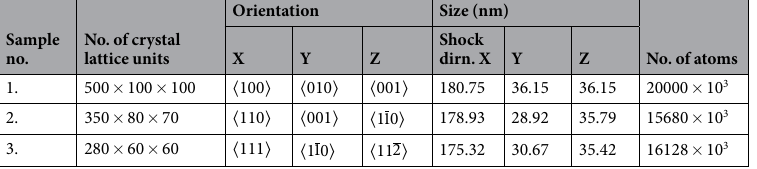
Table 1. Necessary details of the initial configurations of the samples for NEMD simulations with desired orientations. The mass density of all the samples are 8.806 g/cm 3 at ambient temperature and pressure.